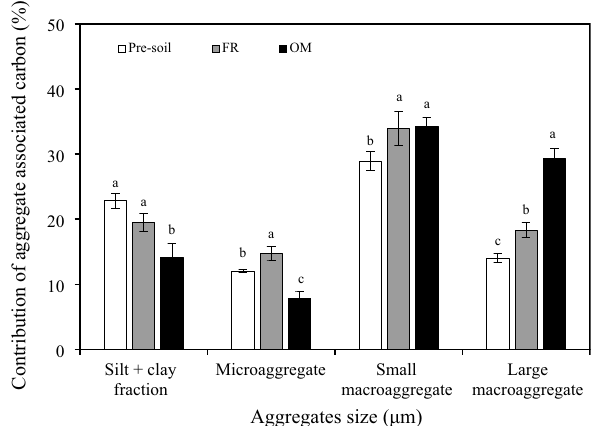
Figure 2. Contribution of the aggregates associated organic carbon amounts to 0-20 cm bulk soil in different treatments. Vertical bars denote the standard error of the mean (n = 3). Different letters a, b and c indicate significant differences between treatments for the same aggregate at p < 0.05. FR chemical fertilizer, OM organic